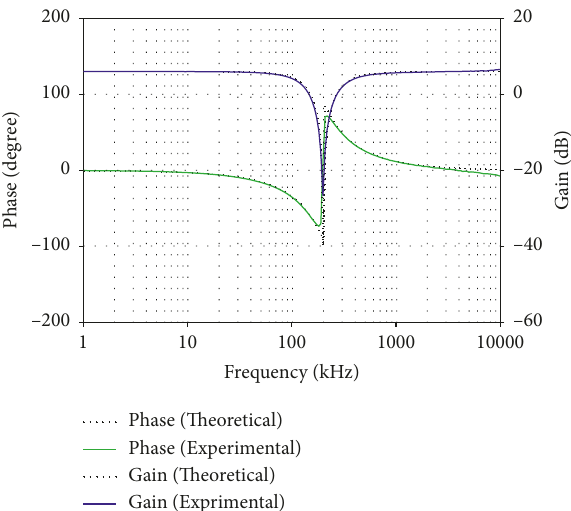
Figure 8: Experiment gain response of band-stop function.